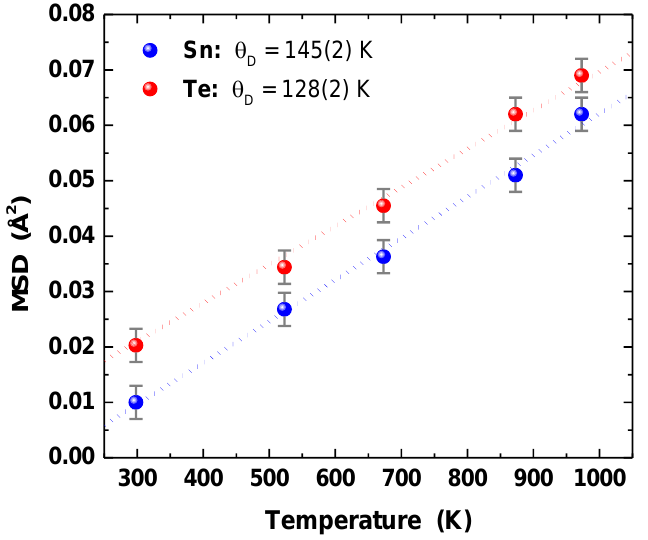
Figure 4. Temperature dependence of the mean-square relative displacements (spheres, MSDs in units of Å 2 ) fitted according to the Debye model (dotted lines).